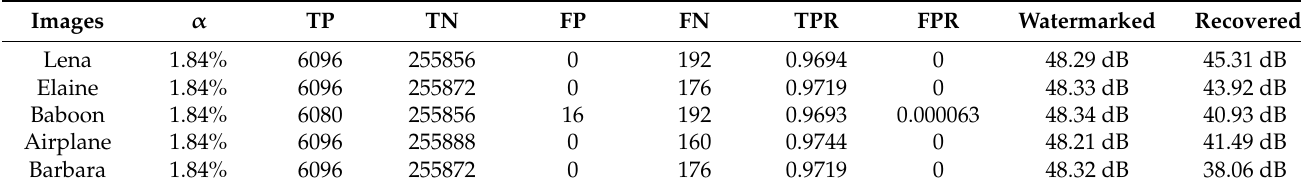
Table 4. Tamper localization and recovery analysis against copy-paste attack 2.